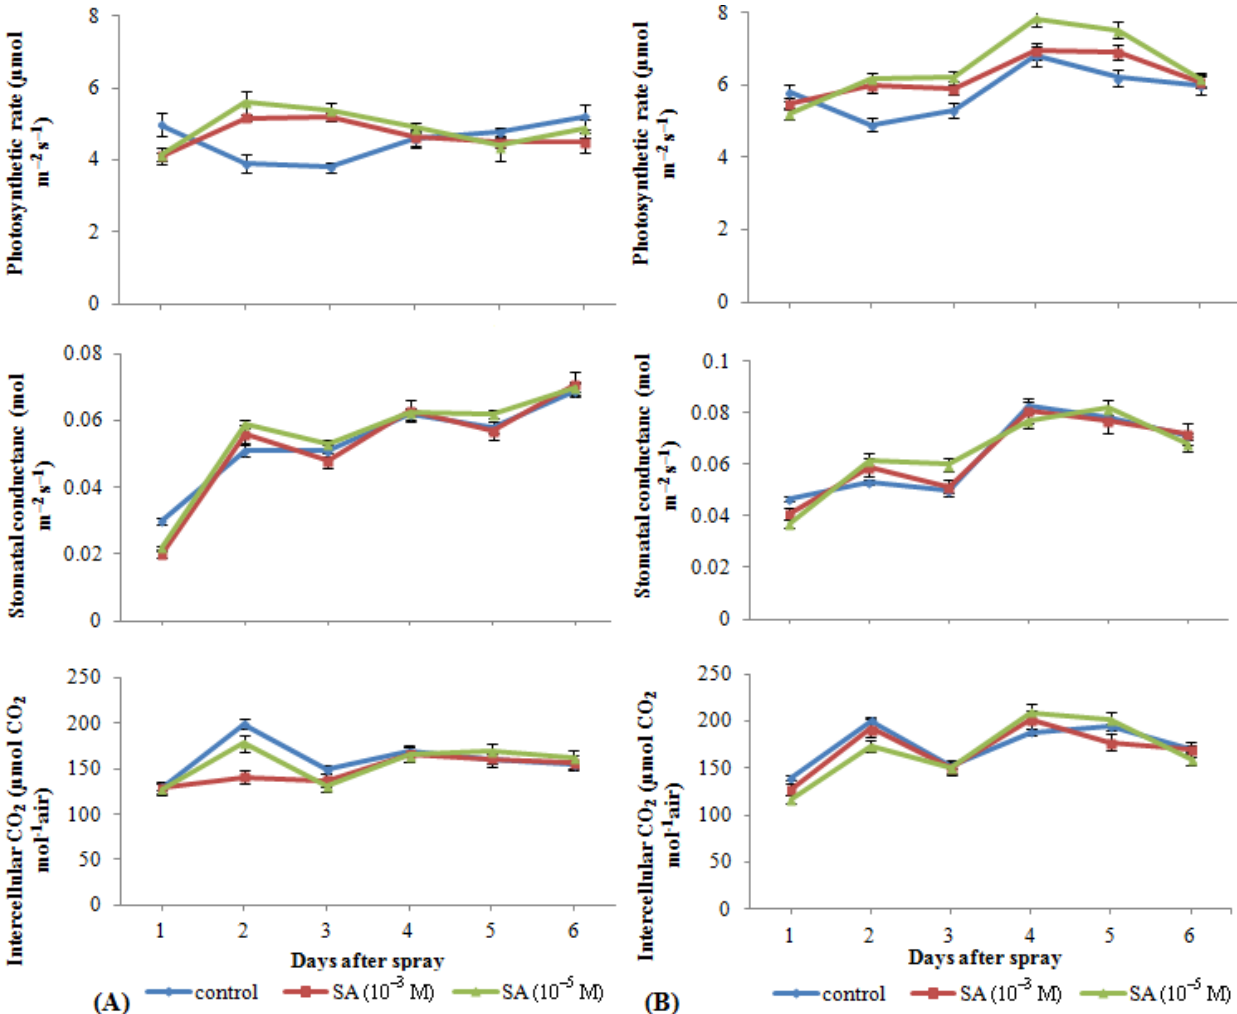
Figure 1. Effect of foliar application of salicylic acid on photosynthetic rate, stomatal conductance and intercellular CO (Ci) in ginger varieties (( A ) Halia Bentong and ( B ) 2 Halia Bara). Error bars indicate means of triplicate measurements ±